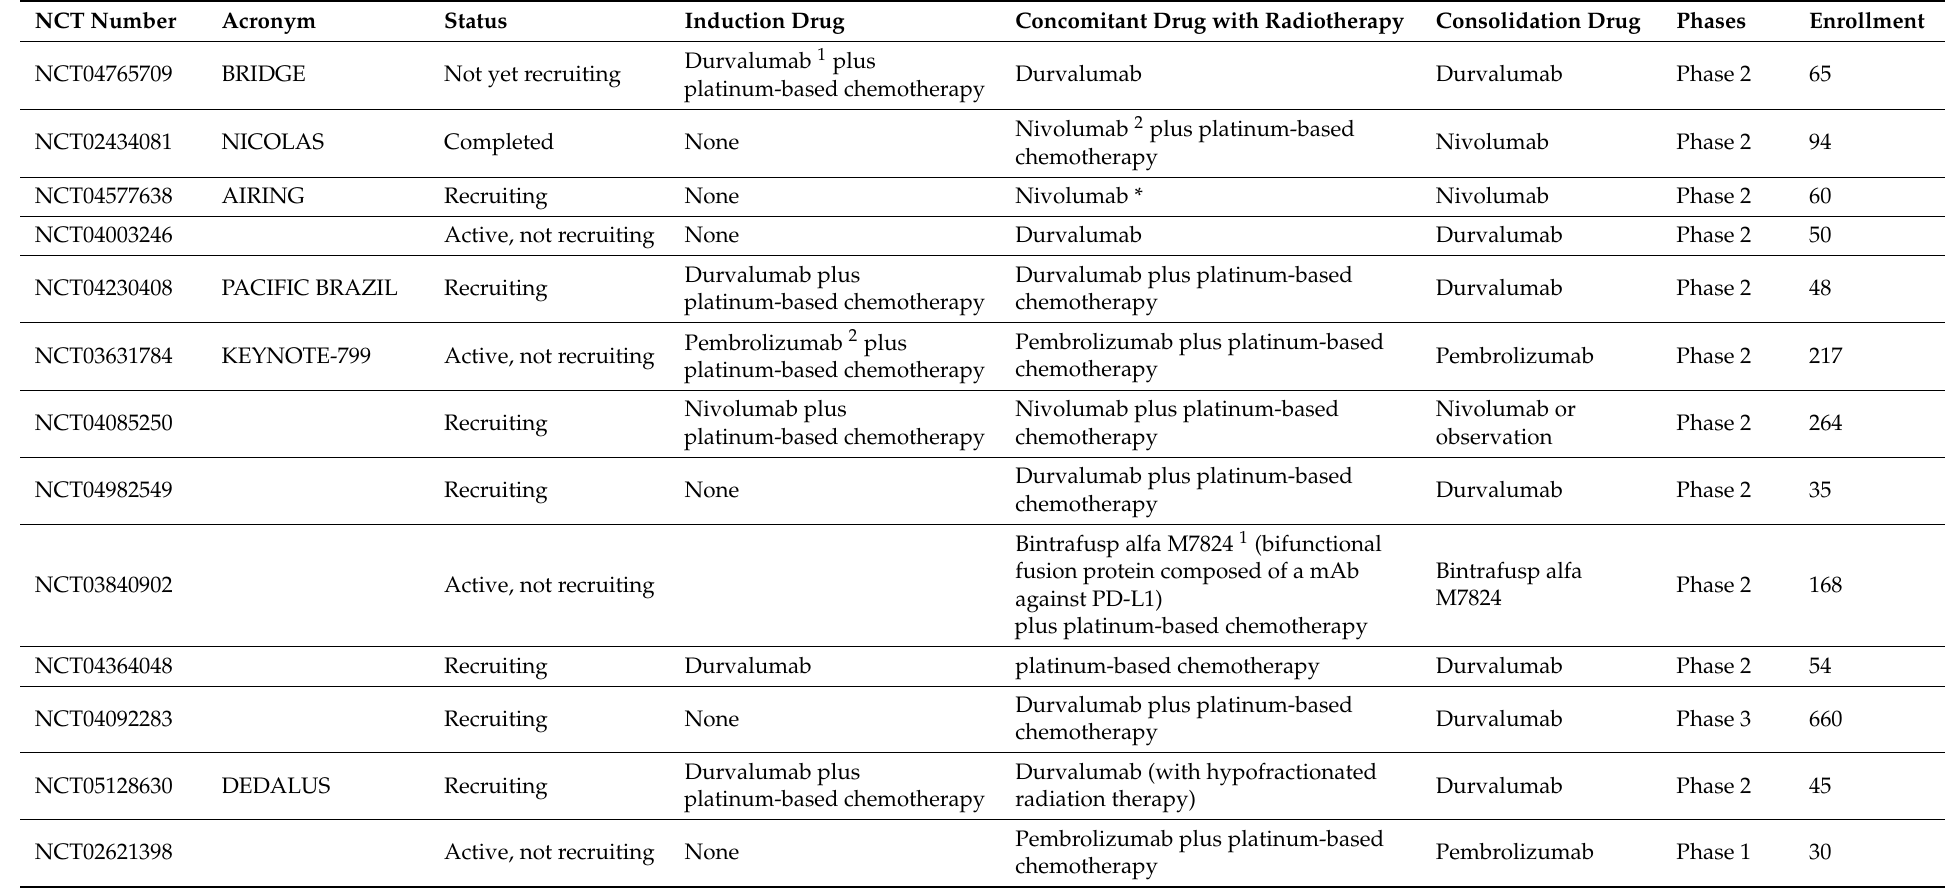
Table 1. Clinical trials in unresectable stage III NSCLCs treated by radiotherapy with concomitant or induction checkpoint inhibitor